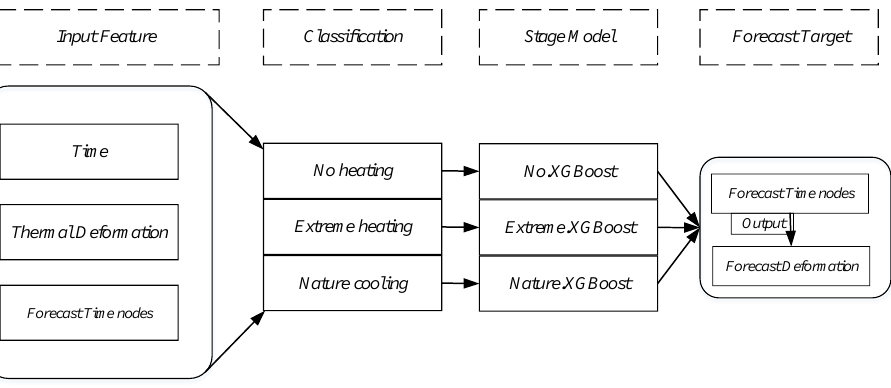
Figure 5. T-XGBoost thermal deformation prediction